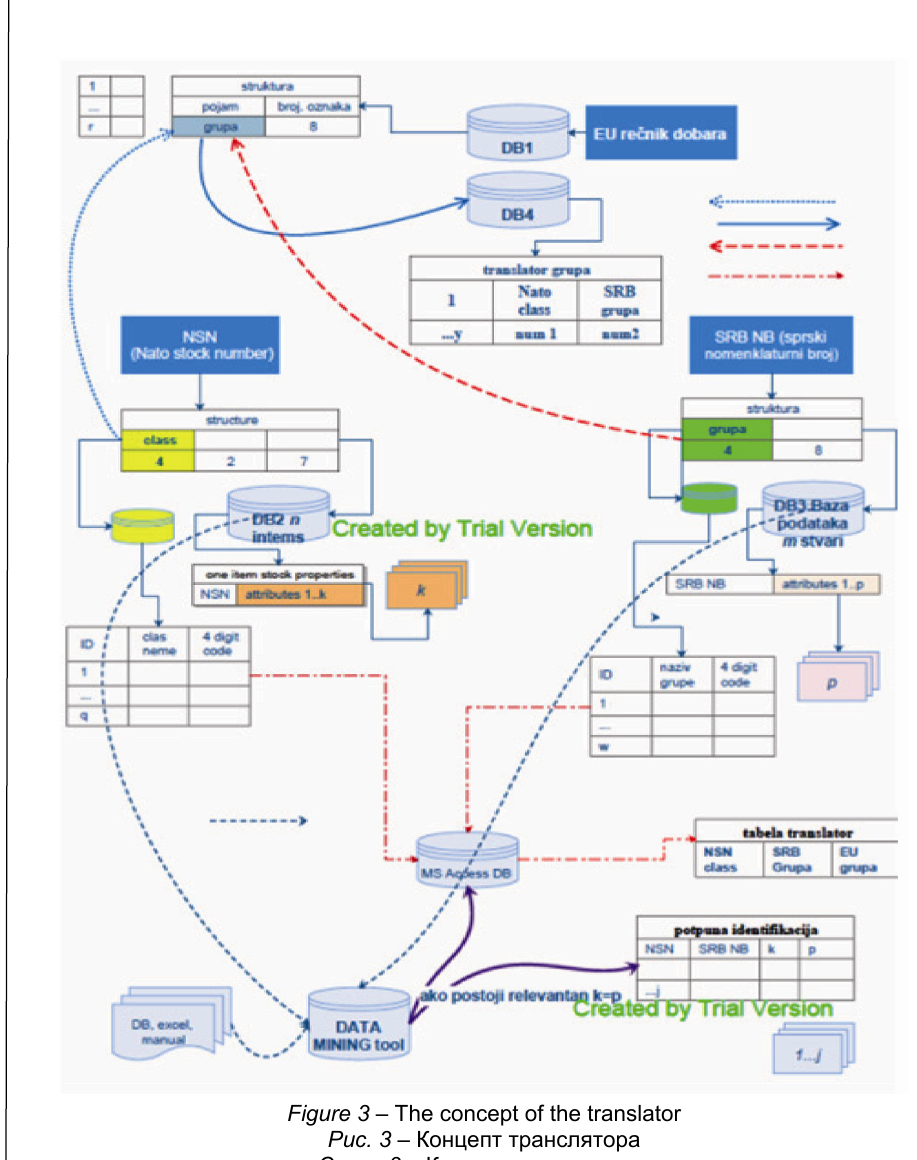
Figure 3 – The concept of the translator Рис . 3 – Концепт транслятора Слика 3 – Концепт